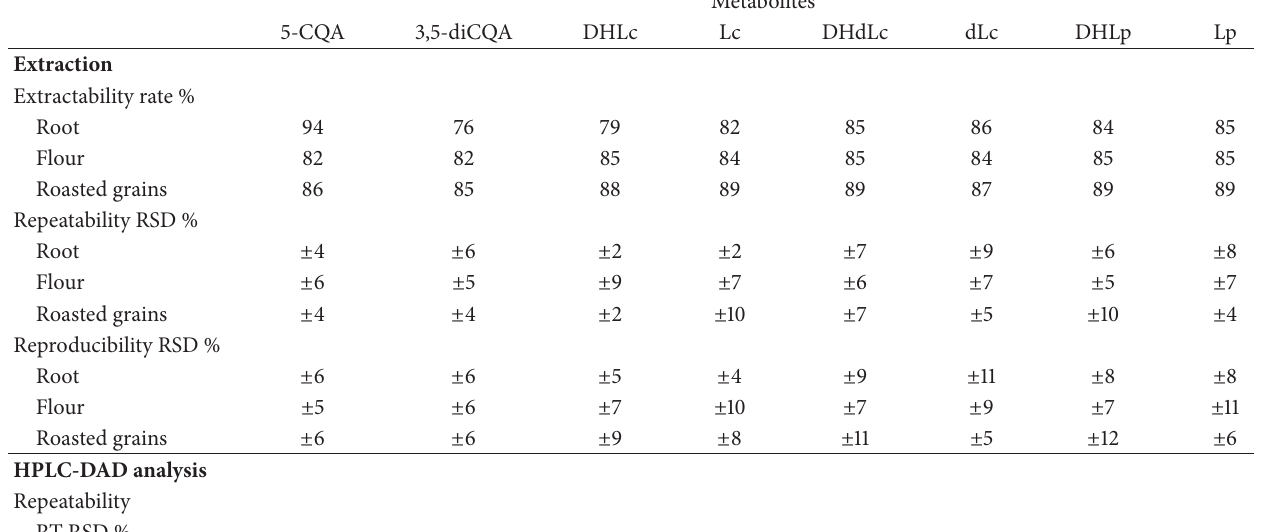
O/CHCl /MeOH 30/30/40 (v/v/v), repeatability, and reproducibility expressed in terms of 2 3